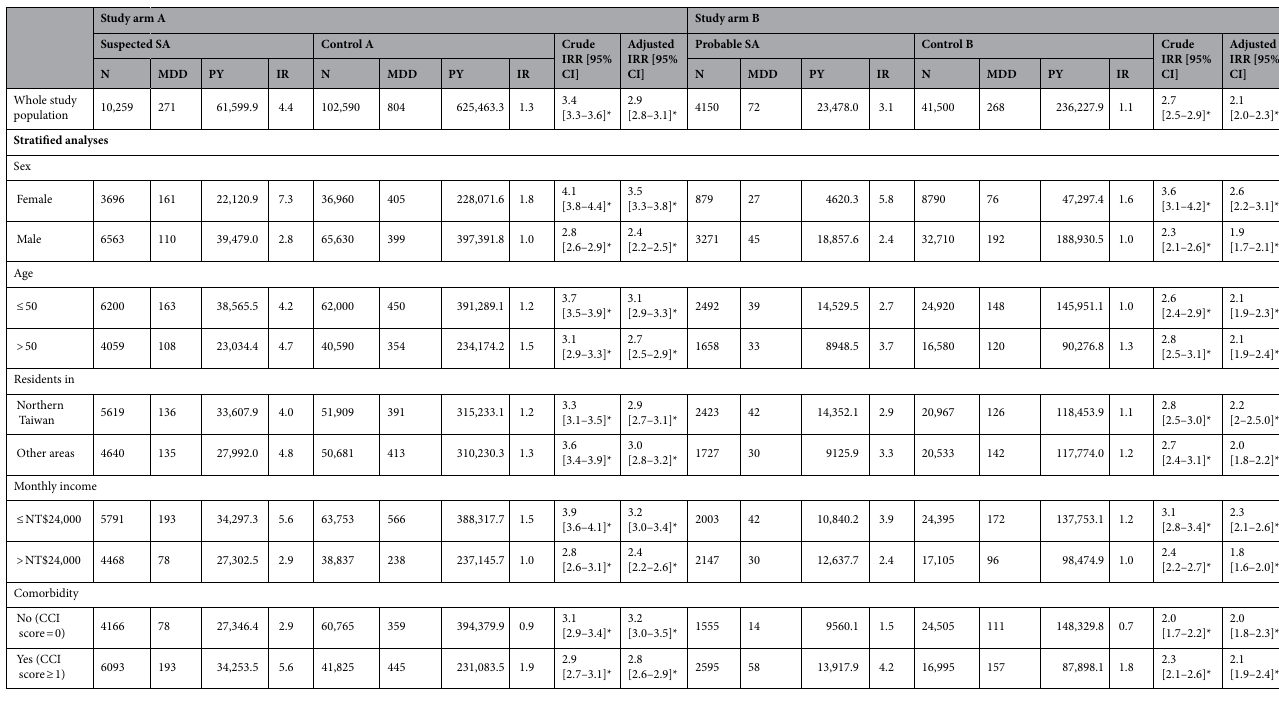
Table 2. Incidence rate of major depressive disorder after the index date. The adjusted IRRs were calculated by multivariable analyses adjusting for sex, age, residency, income and the presence of various comorbidities. (except for the variable used for stratification). * p < 0.0001. NT$ New Taiwan Dollar, CCI Charlson Comorbidity Index, N number of patients, MDD major depressive disorder (number of patients), PY total patient-years, IR incident rate, as expressed as MDD incidence per 1000 patient-years, IRR incidence rate ratio, CI confidence